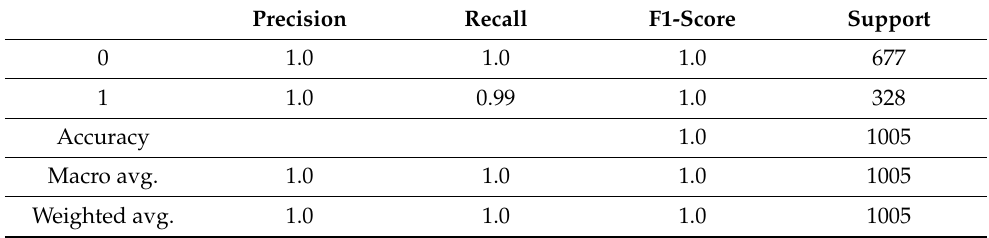
Table 7. Random forest classification report.